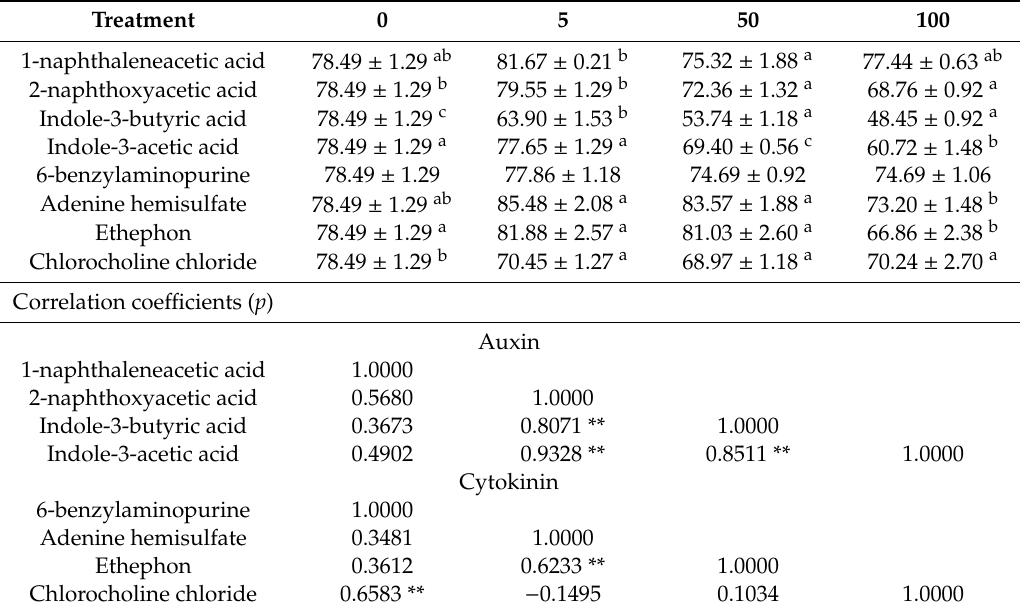
Table 2. The native proteolytic activity after addition of auxins, cytokinins, ethephon and chlorocholine chloride in amounts from 0, 5, 50 a 100 µ g / g dry soil in alpine meadow haplic